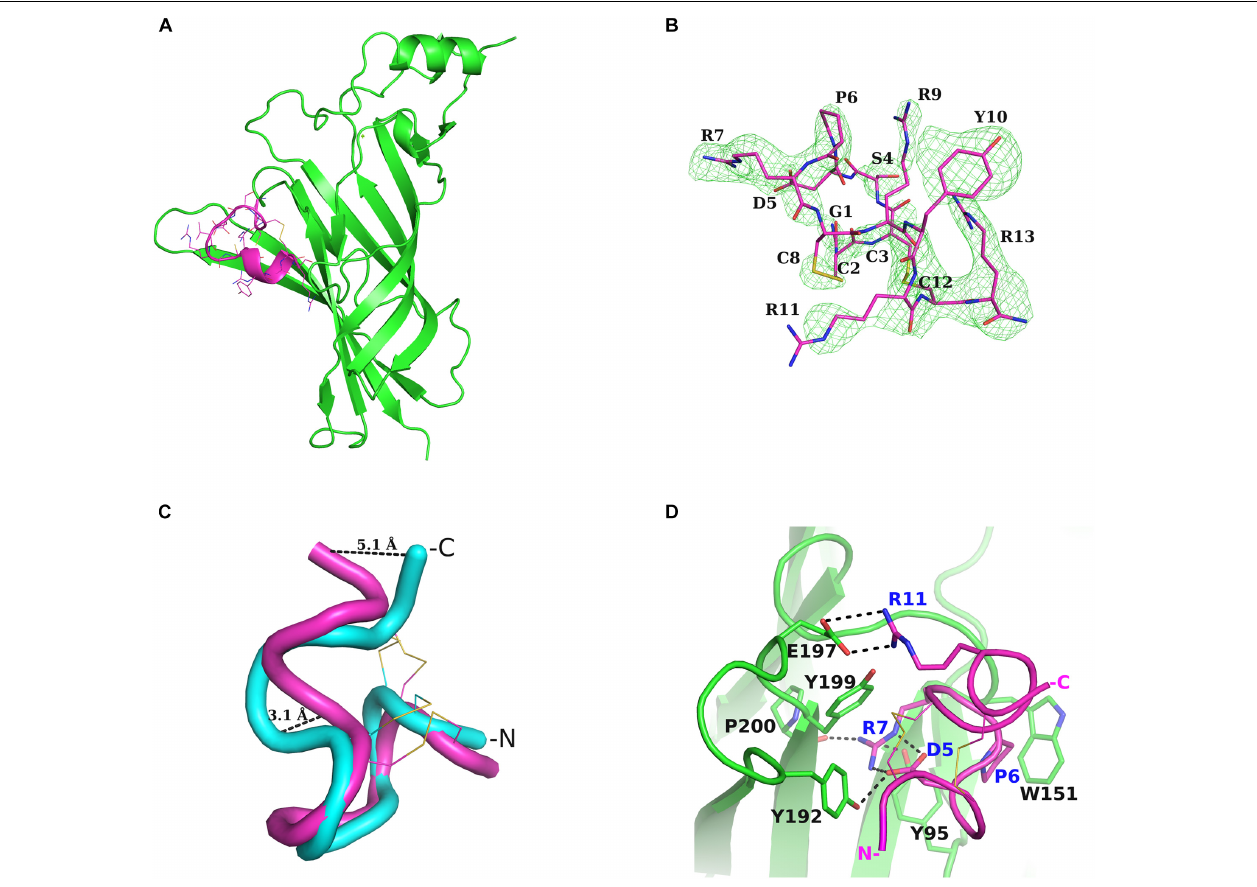
FIGURE 1 | Structure of α -Ctx RgIA bound to nAChR α 9-ECD and interactions. (A) Overall structure of the complex of monomeric α 9-ECD (in green) with α -Ctx RgIA (in magenta). (B) Simulated annealing omit map of the region of the bound RgIA, contoured at 3 σ . (C) Superposition of the NMR structure of RgIA (in cyan) with its crystal structure (in magenta) when bound to α 9-ECD, determined in the present study. The highly diverging regions, at the middle helical domain and at the C-terminus, are shown. (D) Interaction scheme of RgIA with the (+) side of α 9-ECD. The interacting residues are drawn in sticks and the polar or charged interactions are shown in dashed lines. Blue labels account for the RgIA-interacting residues and black labels for the α 9-ECD-interacting